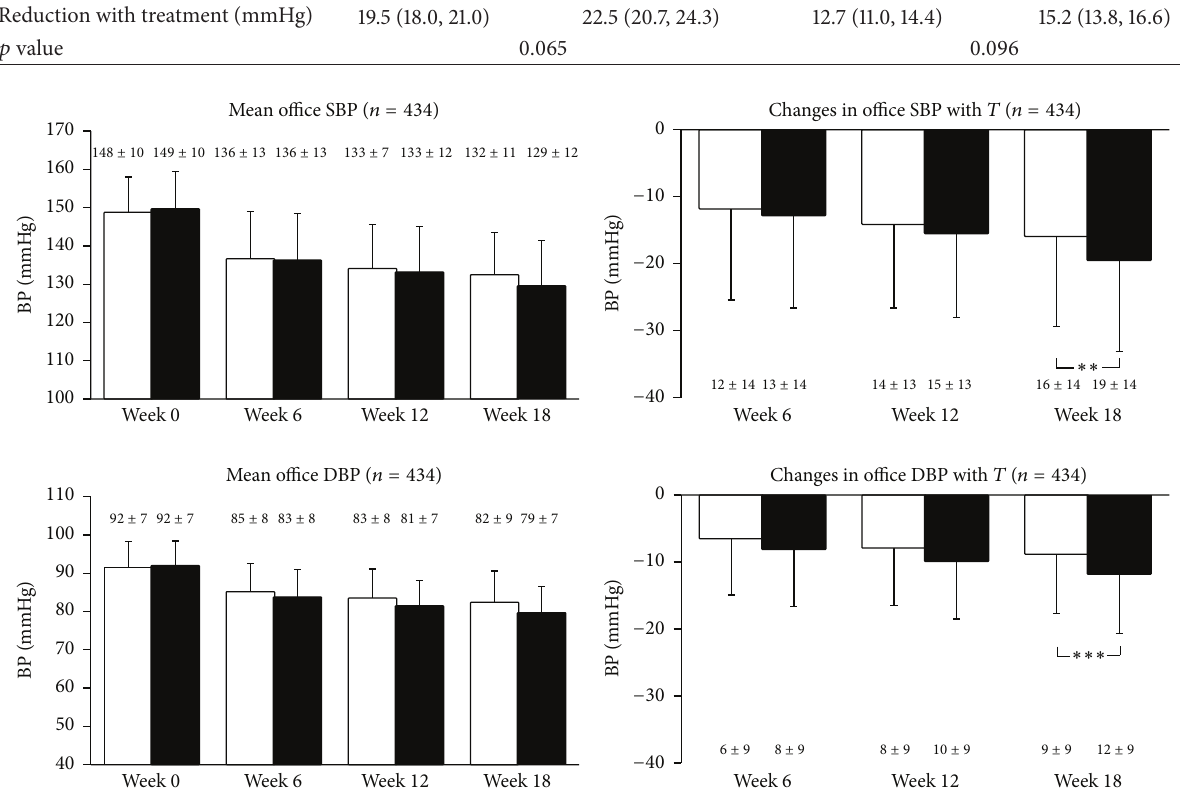
Figure 3: Mean office systolic blood pressure (SBP) and diastolic blood pressure (DBP) values and changes with treatment ( T ) in patients treated with zofenopril 30–60 mg plus hydrochlorothiazide 12.5 mg (open bars) or irbesartan 150–300 mg plus hydrochlorothiazide 12.5 mg (full bars). Data are shown for the intention-to-treat population and as mean values ± SD. Asterisks refer to the statistical significance of the intertreatment differences ( ∗∗ 𝑝 < 0.01 ; ∗∗∗ 𝑝 < 0.001 ).